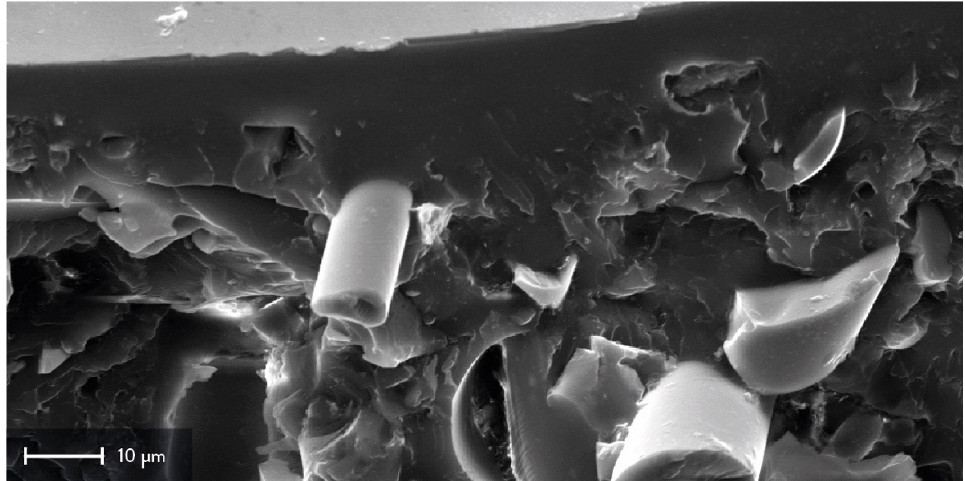
Figure 3. SEM micrographs of a representative cross-section from batch n. 2: insight on the fiber adhesion with the PVD sputtering coating and the UV primer (3k× magnification) highlighted from the cylindrical structure in the middle, which shows a recycled glass fiber.